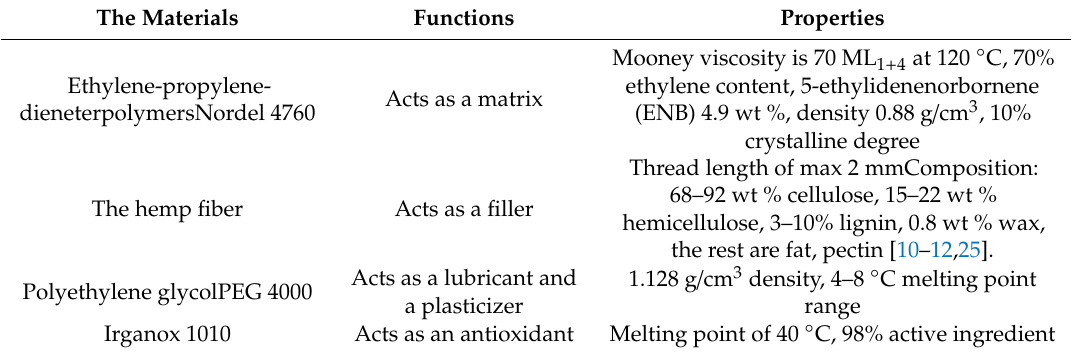
Table 1. The main properties of the materials used.